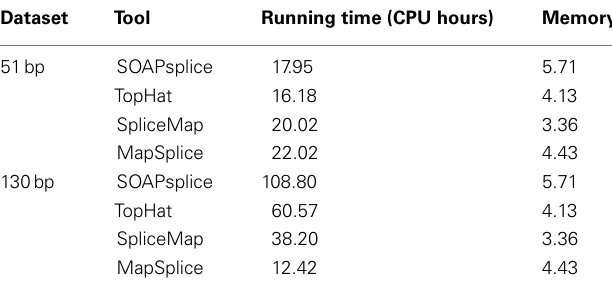
Table 2 | Running time and main memory consumption for the 51 and 130-bp real